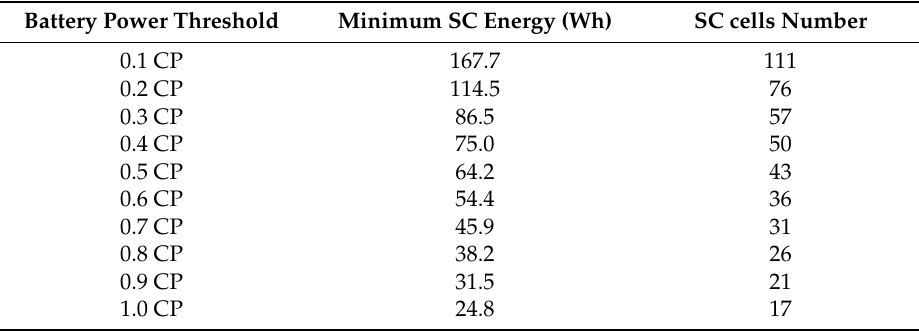
Table 4. CPE values for different powers.